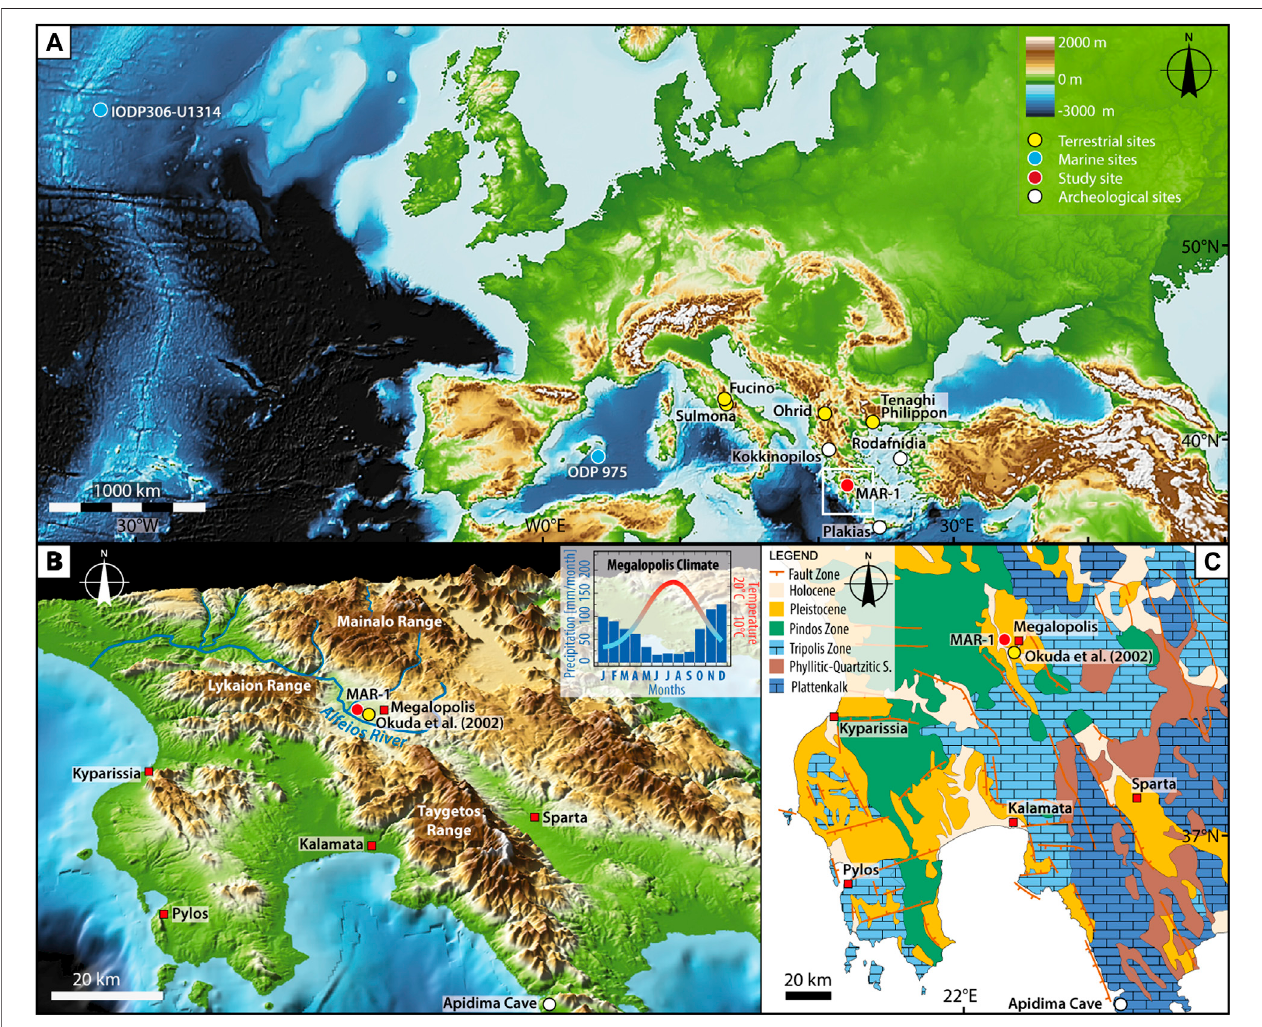
FIGURE1| GeographicalandgeologicalsettingofMAR-1. (A) OverviewmapofEuropeandtheNorthAtlanticwithsitesmentionedinthetext.MAR-1islocatedat 37.24 ° N and 22.05 ° E. (B) 3D image ofSW-Central Peloponnese (by GeoMapApp) showing the location of the archeological site MAR-1 (red circle) and pollen record by Okuda et al.(2002) (yellow circle) in the Megalopolis Basin. The insert shows 40-years climate average of the study region (http://iridl.ldeo.columbia.edu). (C) Geological map of SW-Central Peloponnese modi fi ed after Kleman et al. (2016) for the website http://www.borntraeger-cramer.de/journals/zfg.